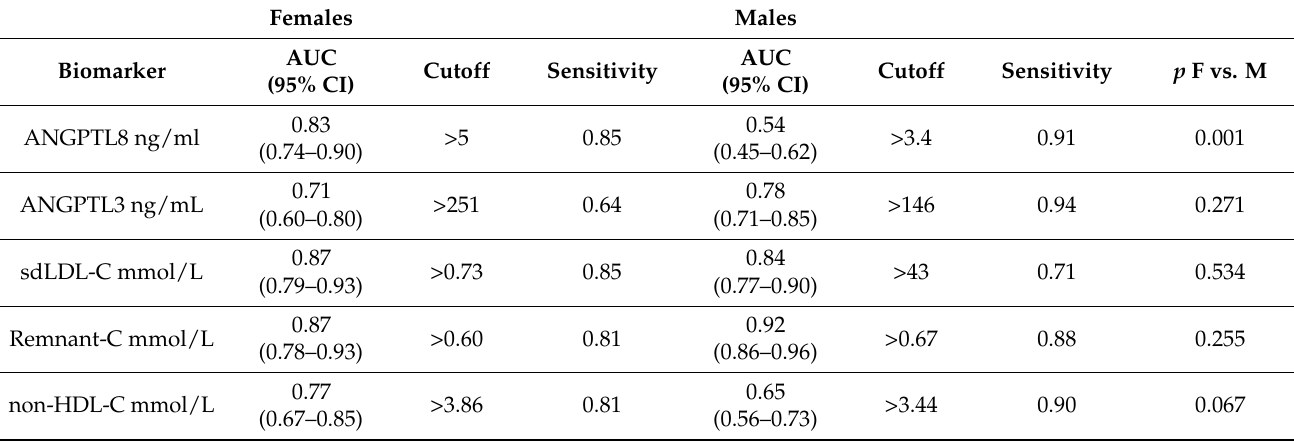
Table 4. ROC analysis and diagnostic ability of evaluated biomarkers to predict hypertriglyceridemia, stratified by gender. Females Males